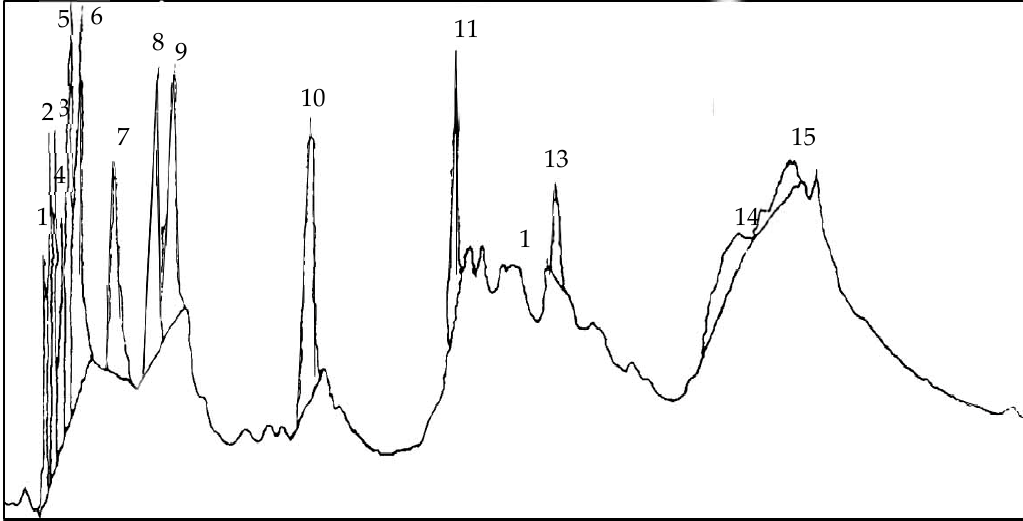
Figure 4. Chromatogram of prosaponin from alkaline hydrolysis of zanhic acid tridesmoside. Peak 11: zanhic acid.